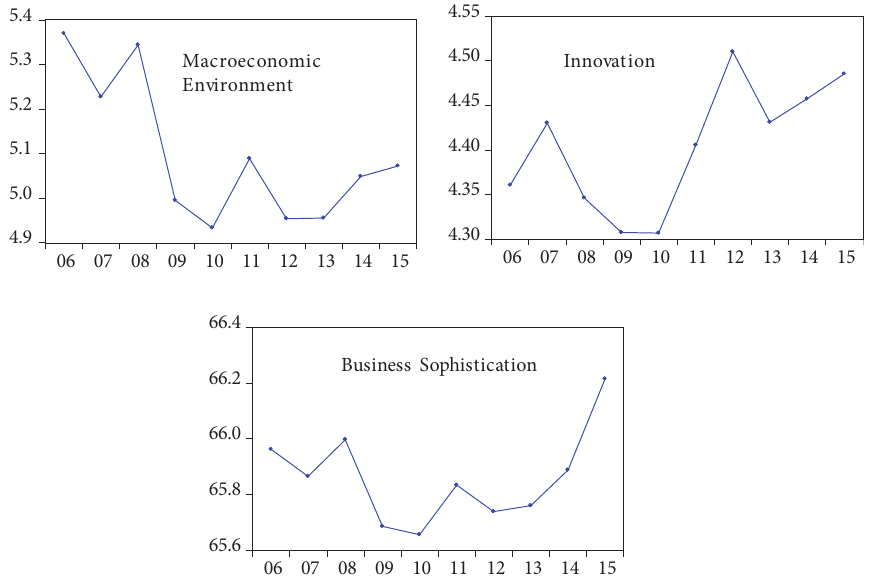
Figure 1. Macroeconomic Environment, Innovation and Business Sophistication in the OECD